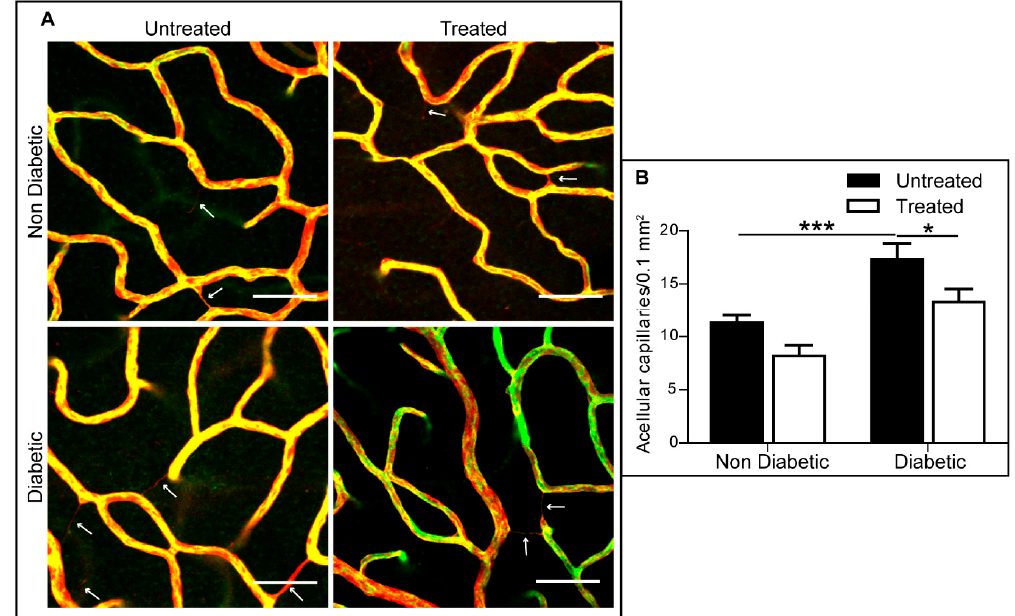
Figure 8. 3TC prevented acellular capillary development in diabetic mice. ( A ) Representative images showing acellular capillaries in diabetic retina and non-diabetic control with or without 3TC treatment. Arrows demonstrating acellular capillaries, which were isolectin B4 (green)-negative and collagen IV (red)-positive. Scale bar: 50 μ m. ( B ) Quantification of acellular capillaries in different groups. Data are shown as mean ± SEM. n > 13 images from 2–3 different animals per experimental condition. Two-way ANOVA with Sidak’s test, * p < 0.05, and *** p < 0.001.